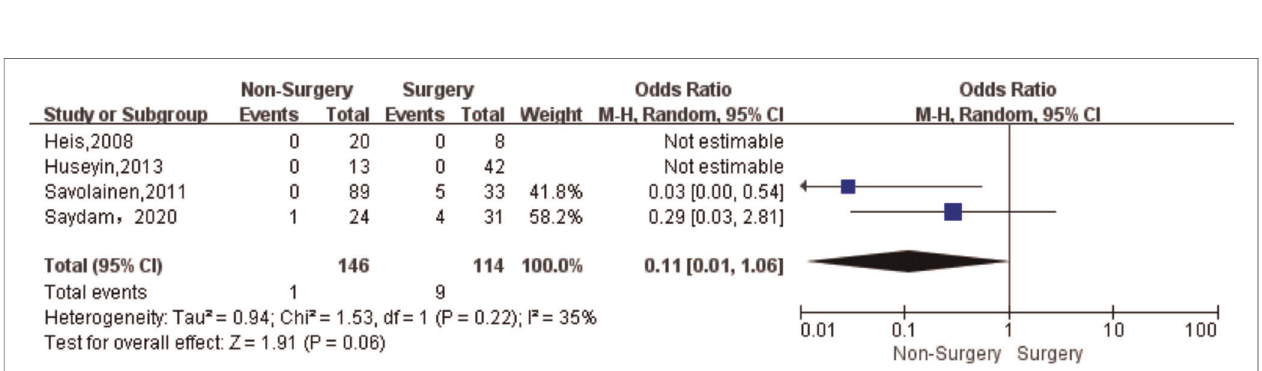
FIGURE 3 | Forest plot showing the pooled odds ratio for pseudoaneurysm treatment complication rate after surgery and non-surgical treatment. CI, con fi dence interval; IV, inverse